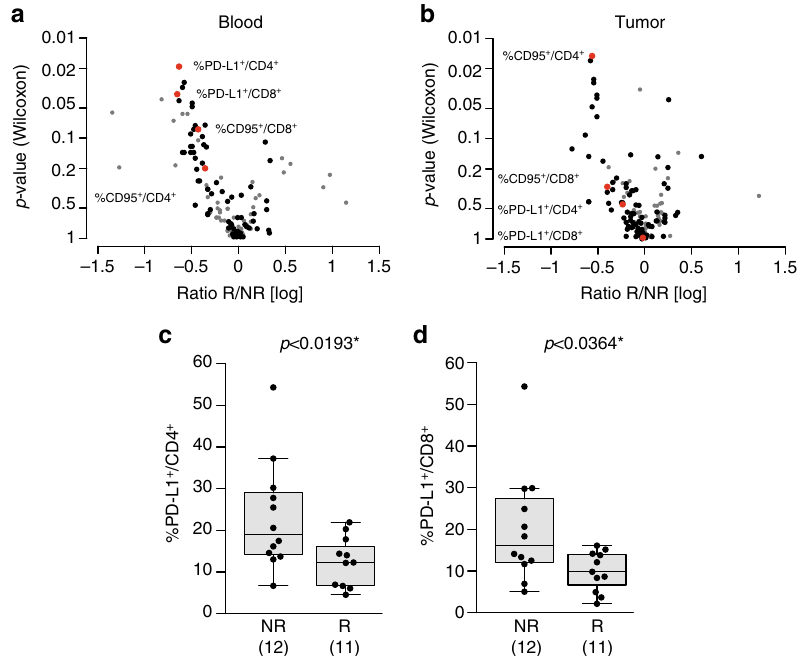
Fig. 3 PD-L1 expression on T cells predicts reactivity to ipilimumab in the “ ex vivo mLN assay ” . a , b Display of the Wilcoxon rank-sum test p -values vs. the log transformed ratio between responders (R) and non-responders (NR) to anti-CTLA-4 Ab in blood a or tumor b samples. Each dot represents one marker; selected biomarkers are shown in red while biomarkers with very low level of expression are shown in gray . c , d Expression levels of PD-L1 on blood CD4 + c and CD8 + d T cells in patient lesions responding (R) or not (NR) to the ex vivo mLN assay using a stimulation with anti-CTLA-4 mAb. Each dot represents one patient. The absolute numbers of patients are indicated in parentheses in both groups. Graphs were analyzed by Wilcoxon rank-sum test. Box and whiskers plots are represented from the corresponding distribution c ,